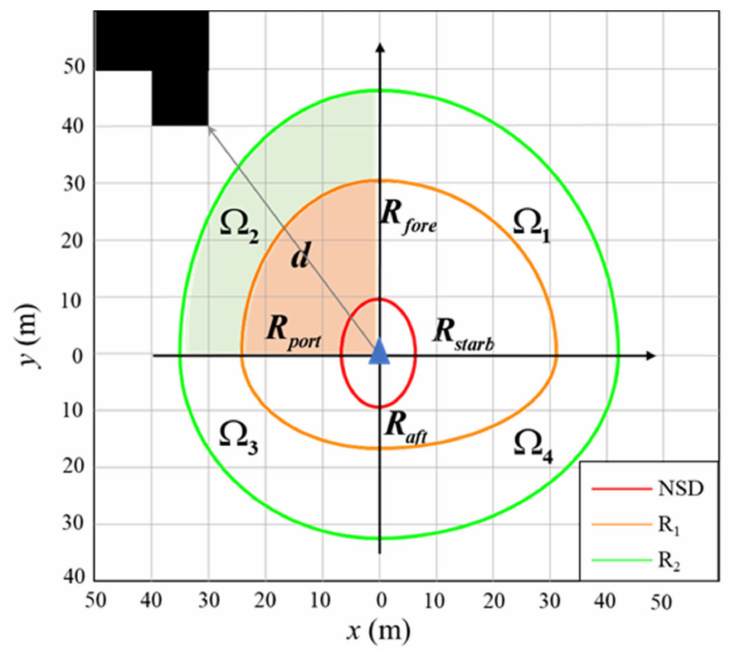
Figure 8. Ship domain model of Dolphin-I